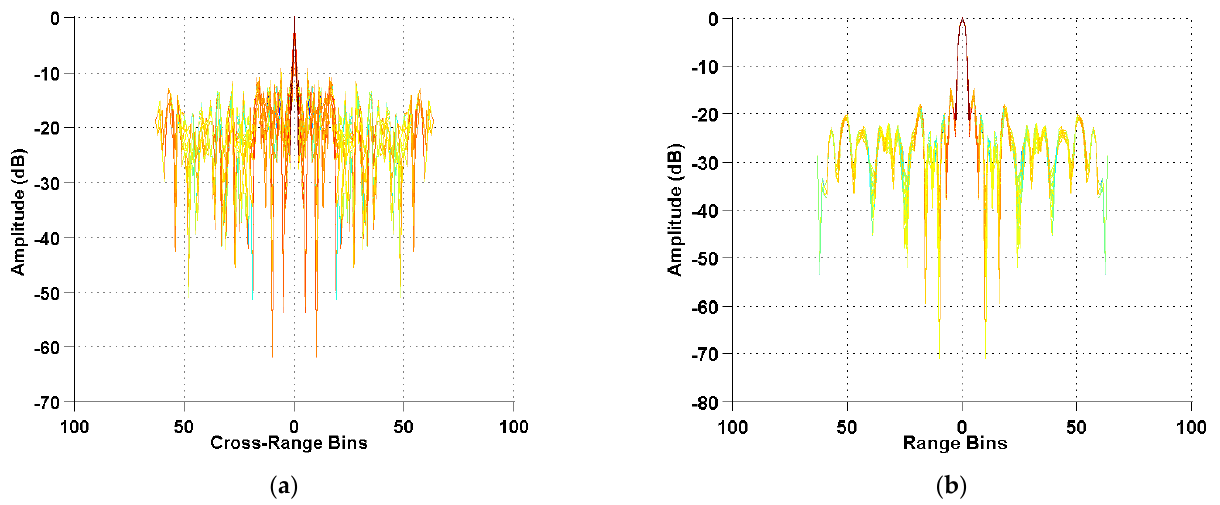
Figure 3. ( a ) The mutual coherence in the cross-range direction. ( b ) The mutual coherence in the range direction.